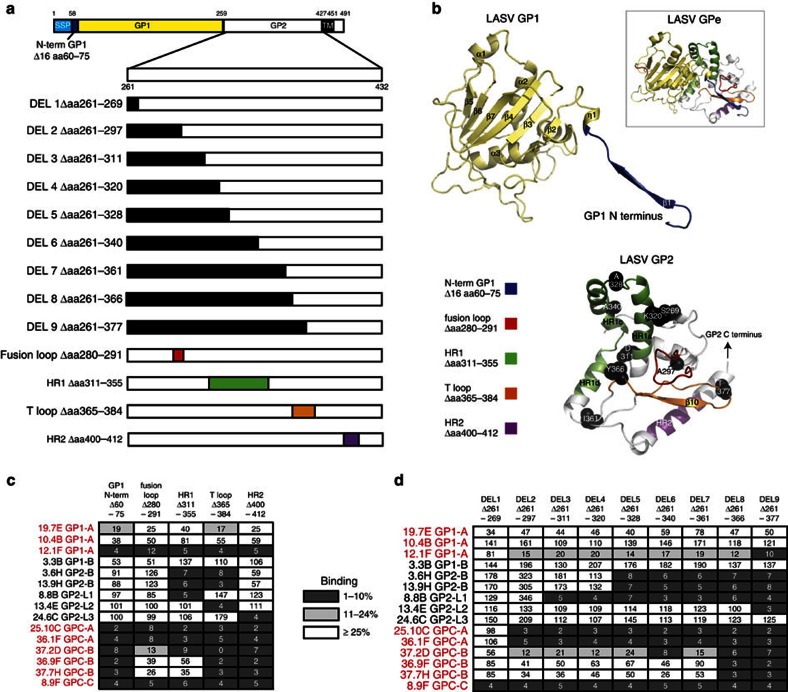
Mapping of putative epitopes recognized by LASV mAbs by deletion mutagenensis.Wild-type recombinant LASV GPC was engineered with deletions of amino-acid sequences to map putative B-cell epitopes on LASV glycoproteins. (a) Location of the N-terminal (N-term) deletion of GP1, nested deletions in GP2 and mutations that delete the fusion loop, HR1, T-loop and HR2 are indicated. Alpha helices and beta sheets are labelled according to Hastie et al.14. (b) Location of deletions in engineered GPC are mapped to structural models of GP1 and GP2 derived from threading of the LASV GPC ectodomain to the structure of LCMV GPC. Deletions are colour coded as in a. The location of the last amino acid of each of the nested deletions in GP is shown as a black sphere. The inset depicts the LASV GPe structural model and interaction of the N terminus of GP1 with the fusion loop and T-loop of GP2 (see also Supplementary Fig. 2a). (c) ELISA reactivity of selected mAbs to GPC constructs containing deletions of the N terminus of GP1 and indicated regions of GP2. ELISA was performed with GPC in Triton X lysates captured in wells coated with ConA. We normalized the binding of mAbs to each mutant by comparing optical density values observed with each mAb reacted with mutated GPC to that observed with unmutated GPC. Values indicate per cent binding with mutant compared with unmutated control. Mutations that resulted in binding that was <10% of binding to unmutated GPC were considered as having a significant effect on mAb binding. Mutations that reduced binding to 10% or less of control or 11–24% of control are highlighted. Reactivity of GP1-B and GP2-L1, L2 and L3 mAbs with each mutant reflected the degree to which mutations had global effects on glycoprotein conformation. An expanded panel of mAbs is presented in Supplementary Fig. 7b. (d) ELISA reactivity of selected mAbs to GPC constructs containing increasingly larger deletions in GP2. An expanded panel of mAbs is presented in Supplementary Fig. 8c. The results shown are representative of multiple (n>4) independent experiments.